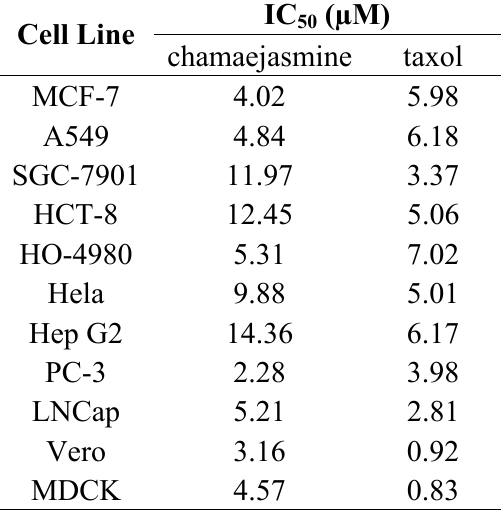
Table 1. Effect of chamaejasmine towards MCF-7, A549, SGC-7901, HCT-8, HO-4980, Hela, Hep G2, PC-3, LNCap, Vero and MDCK cells as determined by the MTT